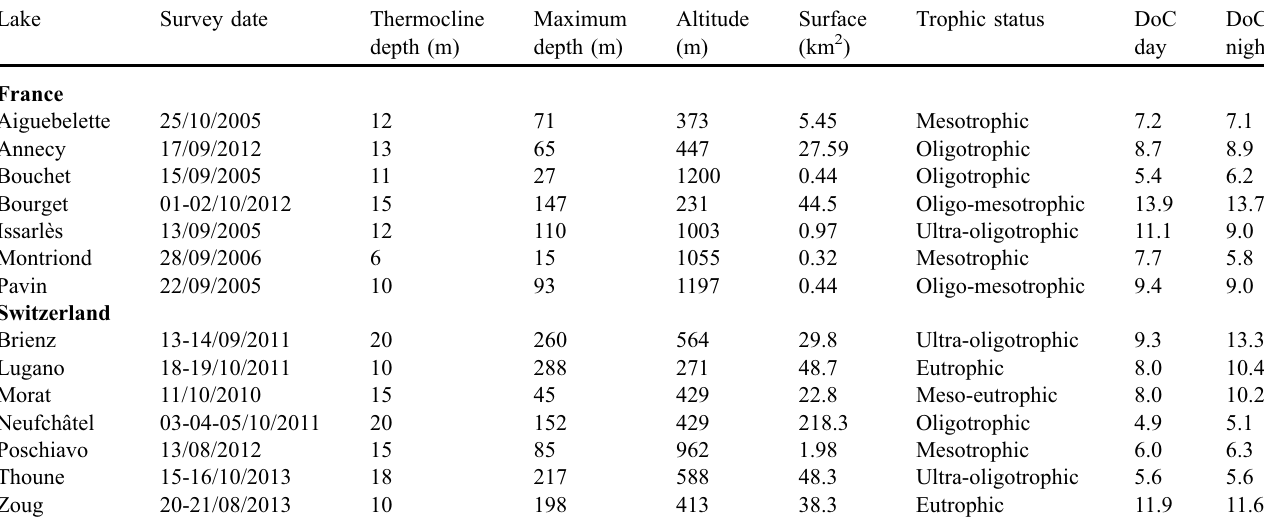
Table 1. Characteristics of the 14 studied lakes. DoC: degree of coverage of acoustics surveys at day-time and night-time.